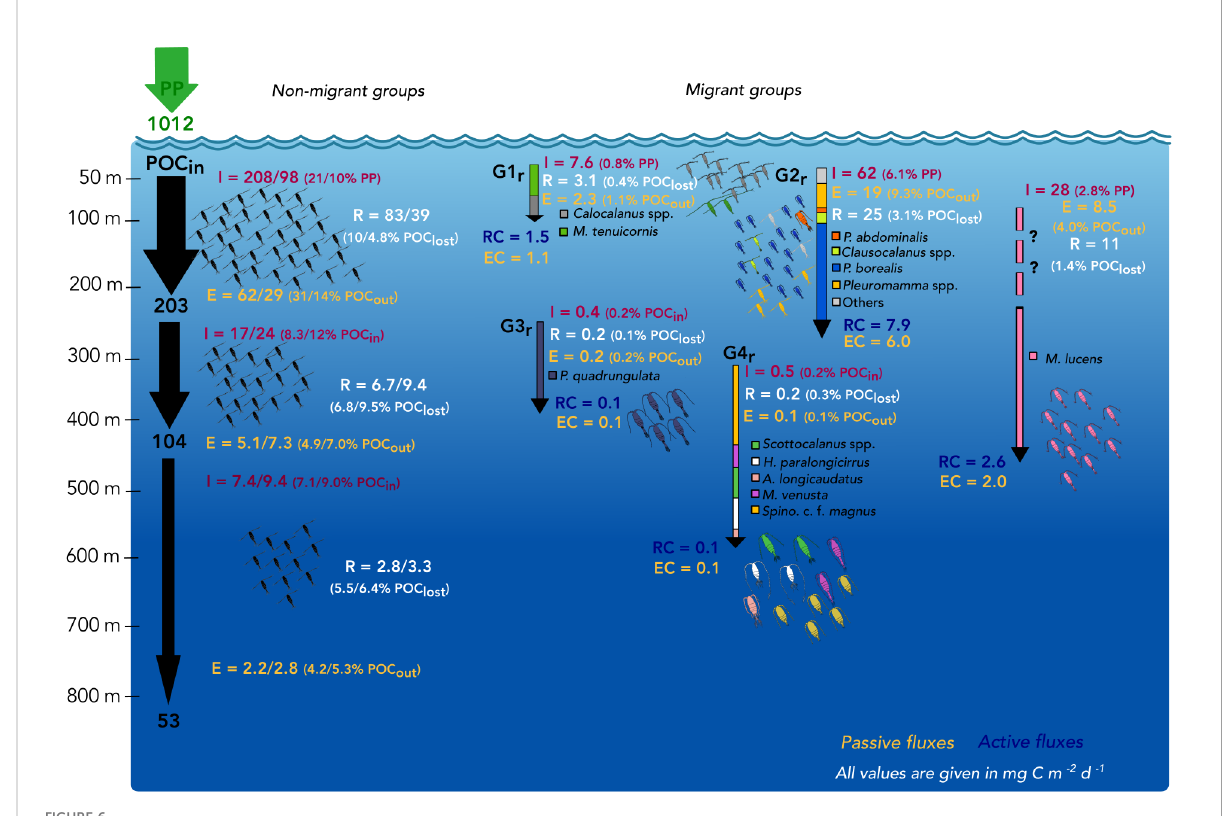
FIGURE 6 Calanoid-mediated processes of removal and transfer of particulate organic carbon (POC). Incoming organic carbon is indicated as primary production (PP) at the surface layers on the left. Incoming (POC in ) and outgoing POC (POC out ) of 200 m, 400 m and 800 m are given after Suess (1980). The non-migrating groups (non-migrant, “ thrifty fl oater ” , undetermined) are summarized on the left giving total community ingestion (I), egestion (E) and respiration (R) for stns. 15/16 in the EL (0-200 m), UML (200-400 m) and LML (400-800 m). Potential impacts of their ingestion on PP or POC in , egestion on POC out and respiration on POC lost are given, the latter indicating the fraction of organic carbon “ lost ” in that speci fi c layer (after Suess, 1980) (POC in - POC out ) and respired as inorganic carbon by copepods. On the right, only the regular migrant groups are shown due to the negligible impact of the inverse migrants in this study. Total community I, E and R are given for each migrant group as well as respiratory carbon (RC) and egested carbon (EC) are indicated with arrows down to the weighted mean depths of each group during the day. Active fl uxes were determined across 100 m, 200 m and 400 m. Metridia lucens was added as separate migrant (large- scale zone shifter), because it was absent at the night station and the maximum potential I, E and R was calculated assuming a migratory portion of 100% into the 0-50 m layer. The “ ? ” indicates this uncertainty. All values are given as mg C m -2 d -1